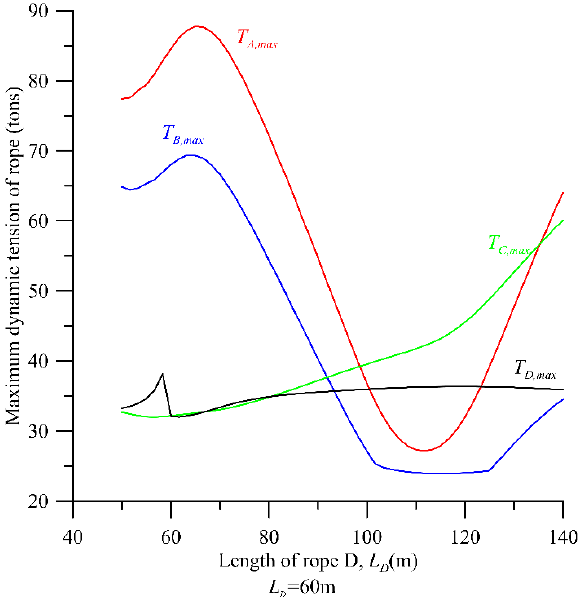
Figure 17. Effect of length of rope D on the dynamic tension ( P T 1 = = ).